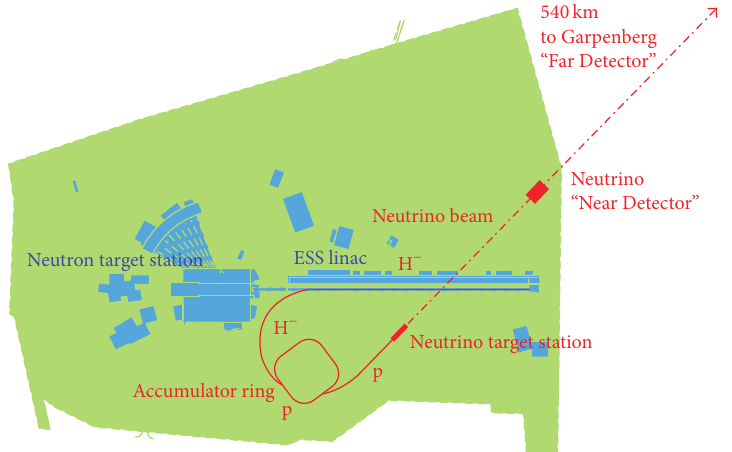
Figure 11: The proposed layout on the ESS site (courtesy of K. Hedin, ESS). The H − beam in the linac, the accumulator and the transfer lines, the neutrino target station, and the neutrino beam are shown in red.